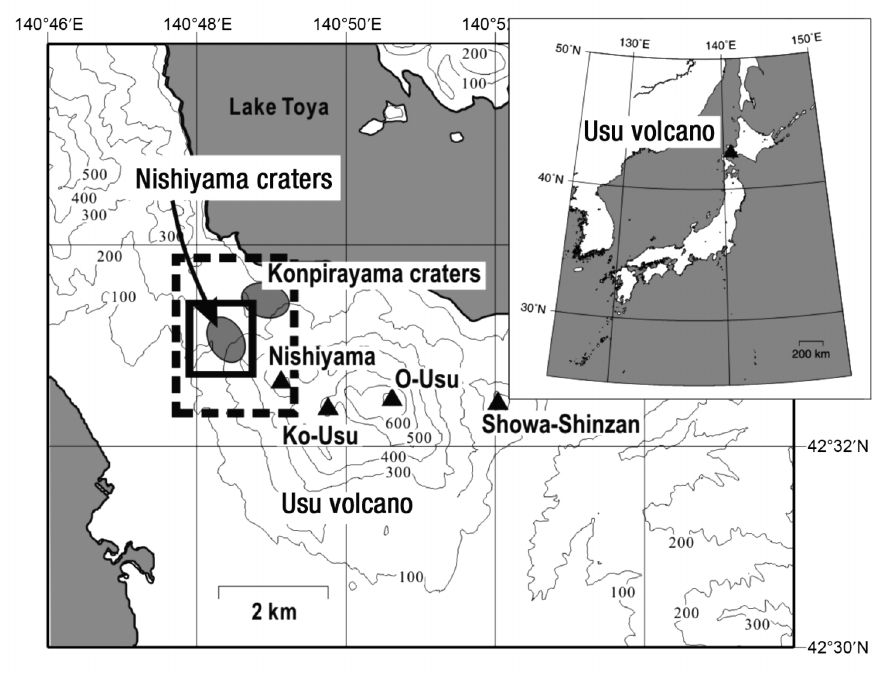
Fig. 1. Topographic map in and around Usu volcano. Contour interval is 100 m. Solid triangles represent two lava domes (O-Usu and Ko-Usu) formed in the past activities. Nishiyama is a topographic high of the Usu somma. The 2000 eruptions of Usu occured within the dashed square. The present study is focused on the solid square